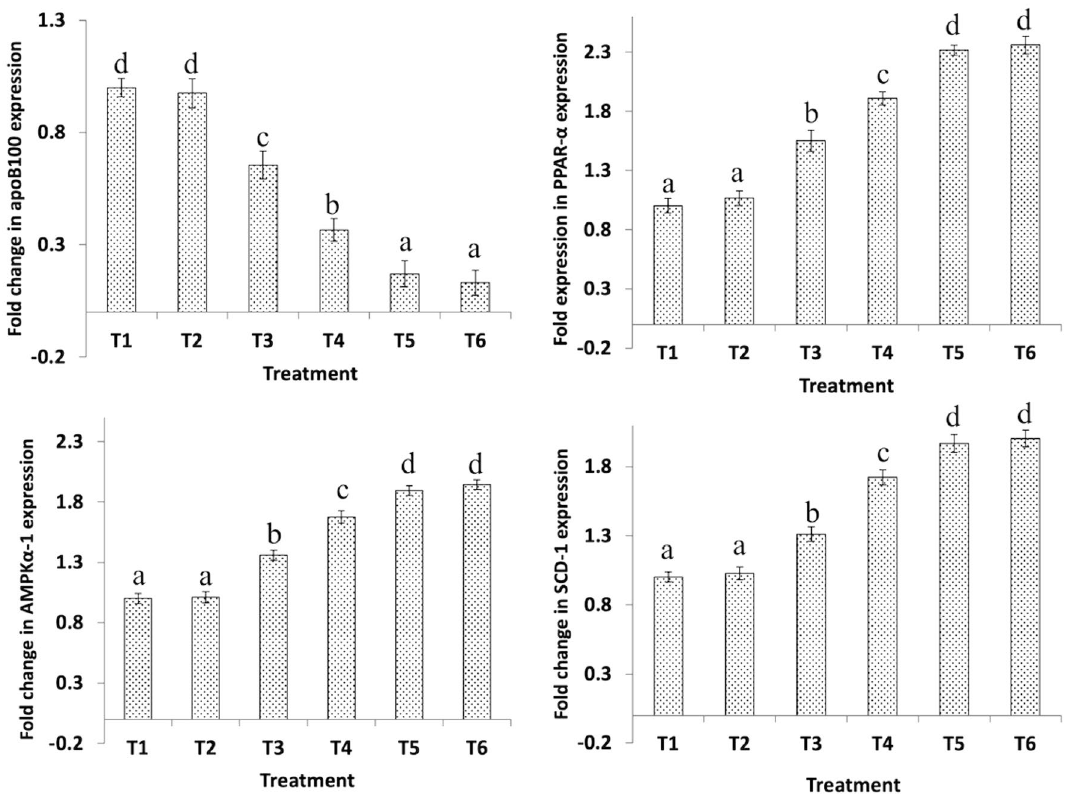
Figure 2. Effect of dietary B. Bifidum (BFD) and mannan-oligosaccharides (MOS) on hepatic apoB100, PPAR-α, AMPKα-1, and SCD-1 gene expression in 21 days old broiler chicken. T 1 (no BFD/MOS/BMD), T 2 (20 mg BMD/kg diet), T 3 (0.1% MOS + 10 6 cfu BFD/g feed), T 4 (0.1% MOS + 10 7 cfu BFD/g feed), T 5 (0.2% MOS + 10 6 cfu BFD/g feed), T 6 (0.2% MOS + 10 7 cfu BFD/g feed). Results are presented as means ± SEM with six birds per treatment. Means values with different superscripts letters differ significantly (P <